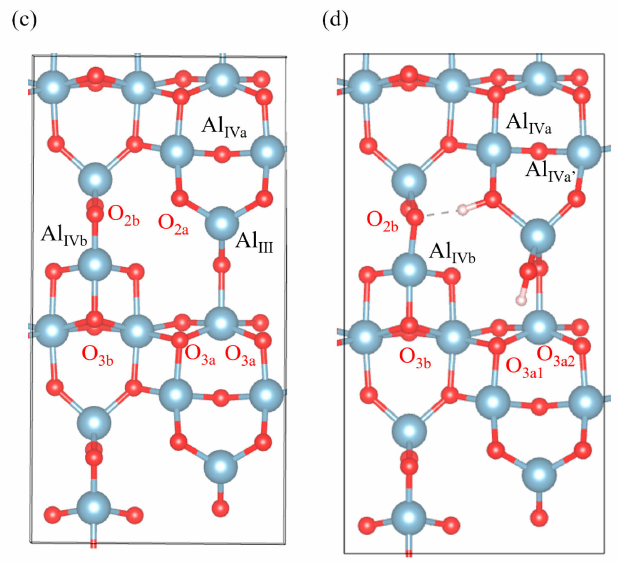
Figure 1. Top view of catalyst surface models of ( a ) dry t-ZrO 2 (101); ( b ) hydroxylated t-ZrO 2 (101); ( c ) dry γ -Al 2 O 3 (110); and ( d ) hydroxylated γ -Al 2 O 3 (110). We model Al 2 O 3 as a 2 × 1 unit cell (dimensions 8.40 Å × 16.14 Å × 27.40 Å) of